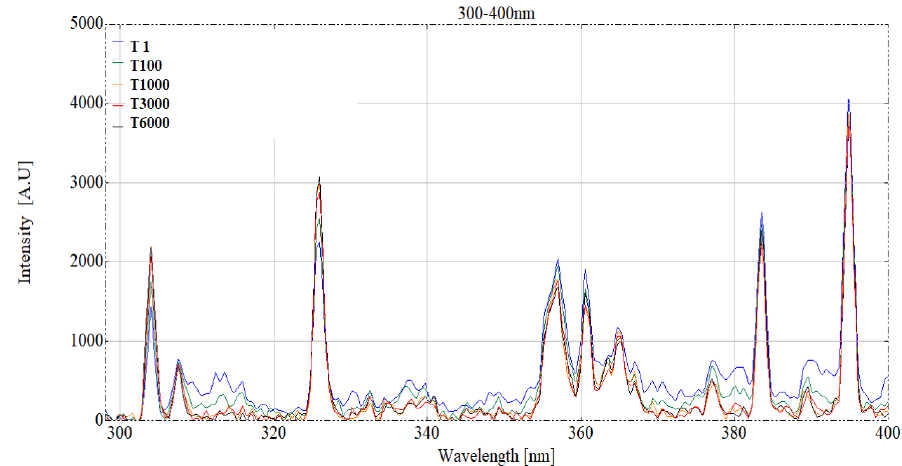
Figure 11. The detailed emission spectra of the plasma between 300 and 400 nm during the deposition of the S5 sample are presented. Three of the peaks demonstrate a gradual intensity increase at time intervals of 1, 100, 1000, 3000 and 6000 s post plasma ignition, while the rest of the spectrum demonstrates a gradual decrease. This region of the spectrum demonstrates significant changes, yet it has not been utilized in colour function calculations.